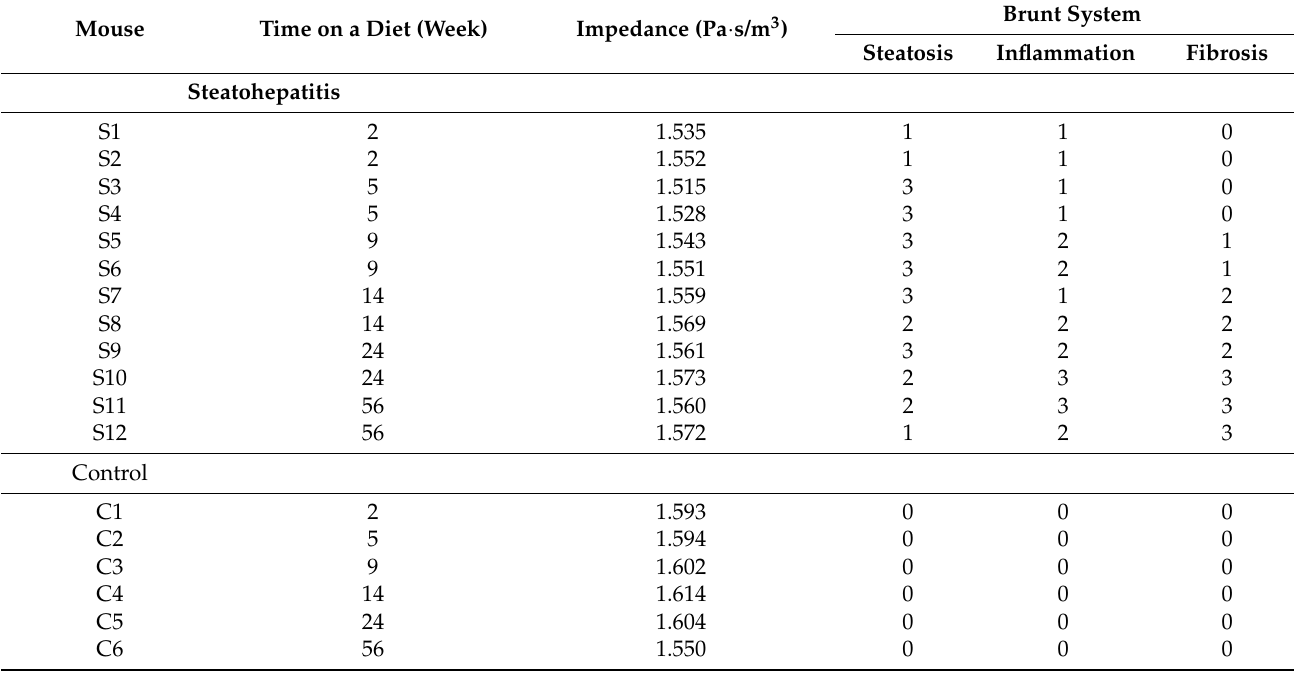
Table 1. Ultrasonic and pathologic properties of livers from both control mice and mice with steatohepatitis. Mouse Time on a Diet (Week) Impedance (Pa · s/m 3 )